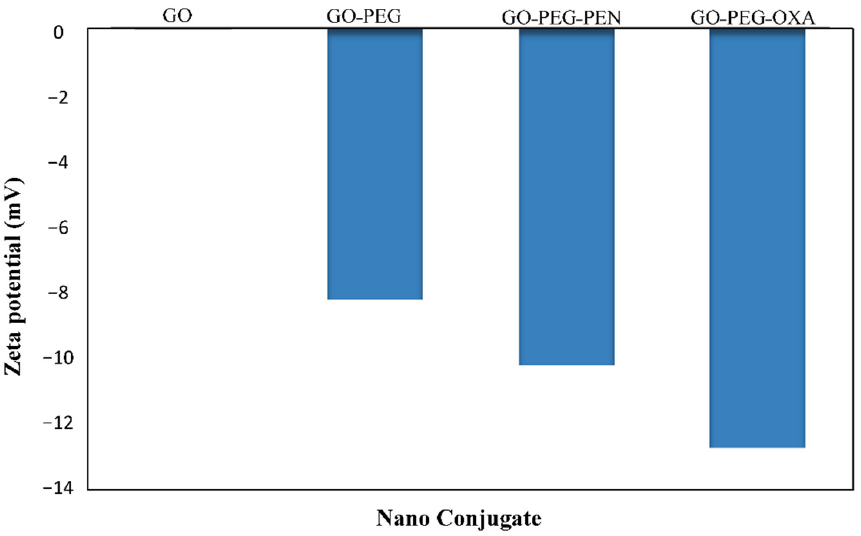
Figure 5. Zeta potentials of GO, GO-PEG, GO-PEG-PEN, and GO-PEG-OXA.